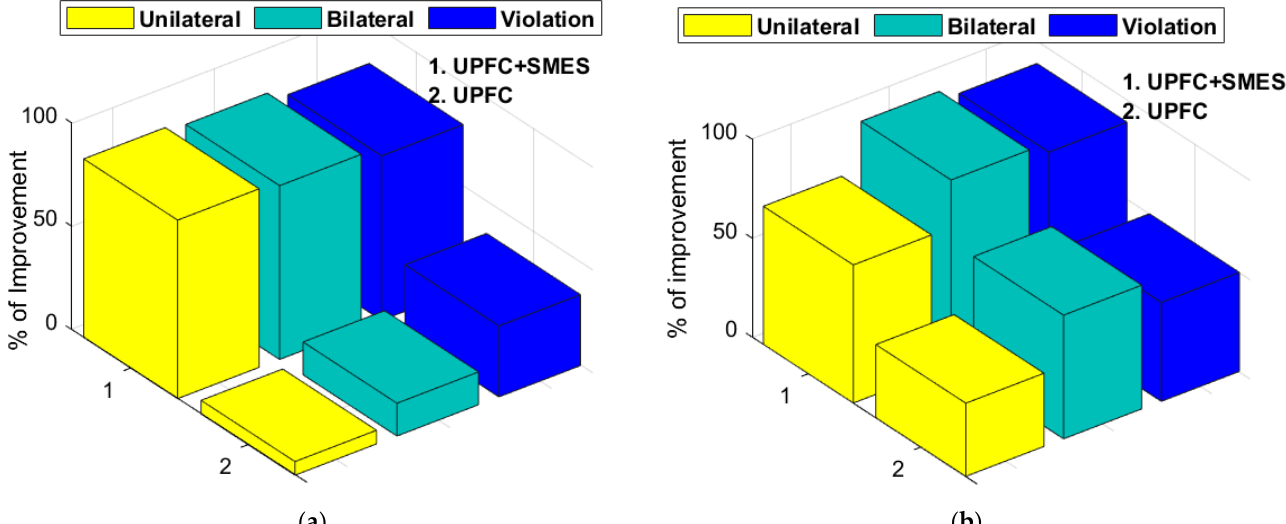
Figure 17. Comparison of the impact of ancillary device on deregulated power system operation in the case of three contracts with respect to the tie-line power deviation—percentage improvements relative to the case without ancillary: ( a ) tie-line power improvement (settling time); ( b ) tie-line power improvement (overshoot).